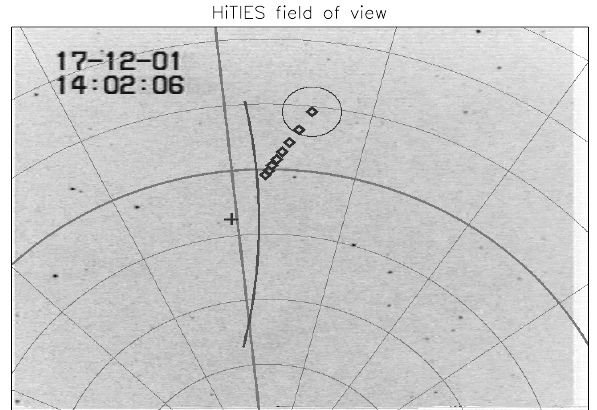
Fig. 1. Fields of view of the SIF instruments and the ESR. The cross is the direction of the magnetic zenith. The ESR beam is shown as the circle at 100km altitude. Diamonds show the centre of the beam at altitudes between 100km and 240km with 20km